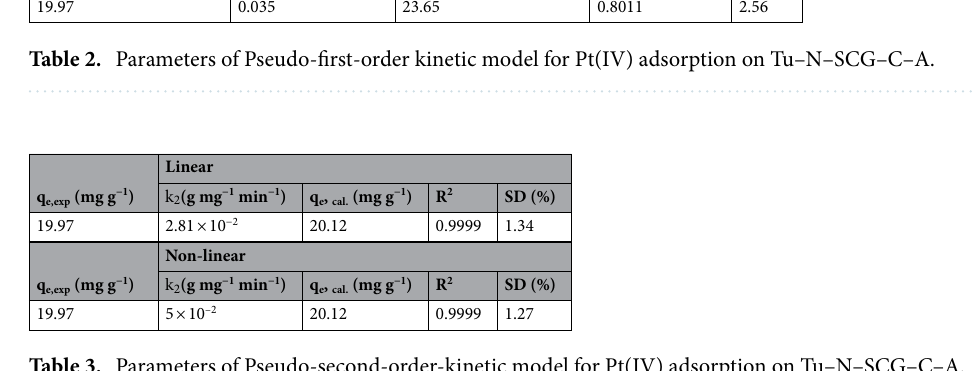
Table 3. Parameters of Pseudo-second-order-kinetic model for Pt(IV) adsorption on